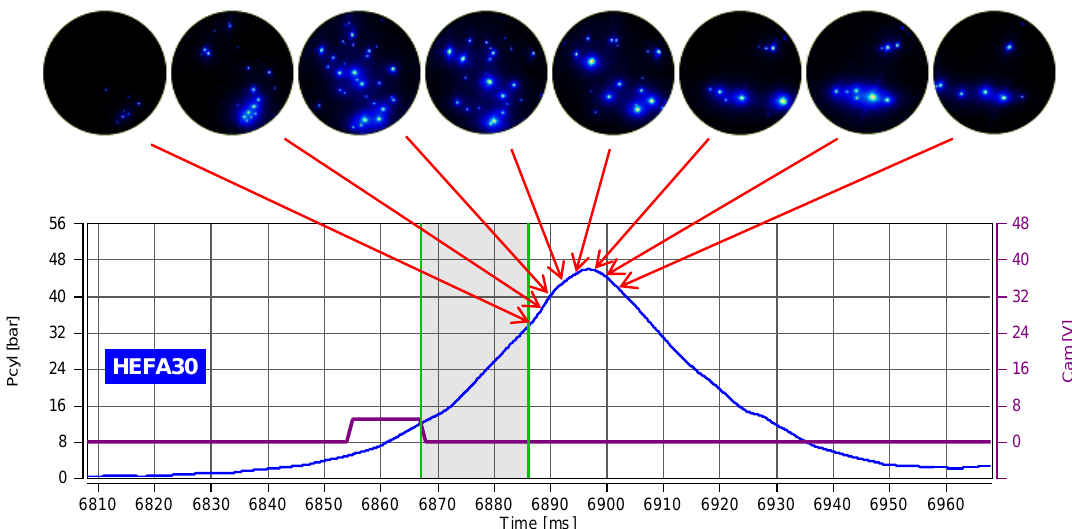
Figure 17. Location of the autoignition spots on the indicator graph during the combustion of the HEFA30 fuel (dt for the images: 2.5 ms).